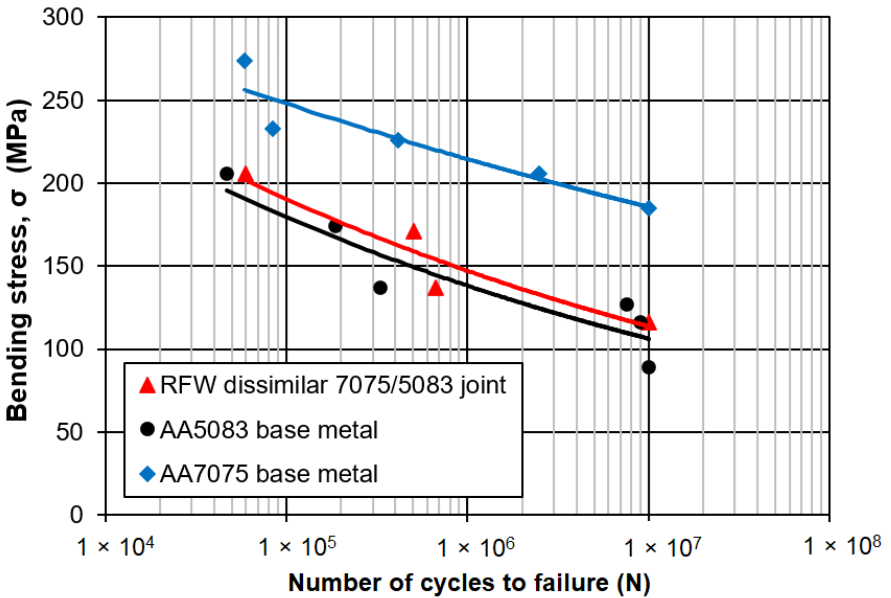
Figure 14. S-N curves of the rotary friction welded AA7075/AA5083 joint at 1200 rpm with its base metals.